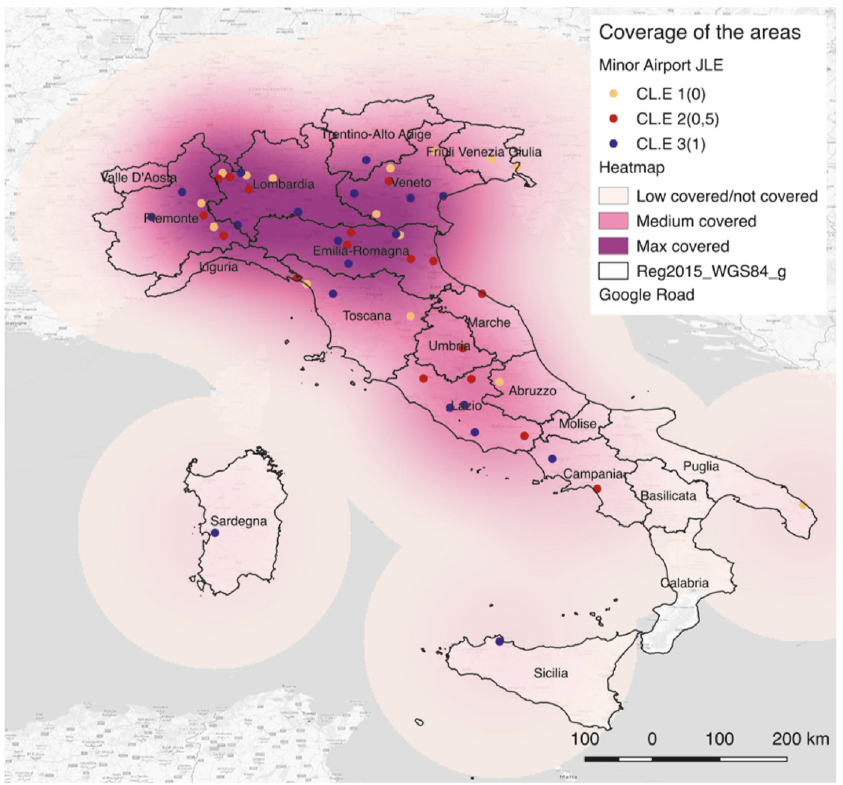
Figure 12: Definition of coverage of the areas by minor airports throughout the country: heatmap.